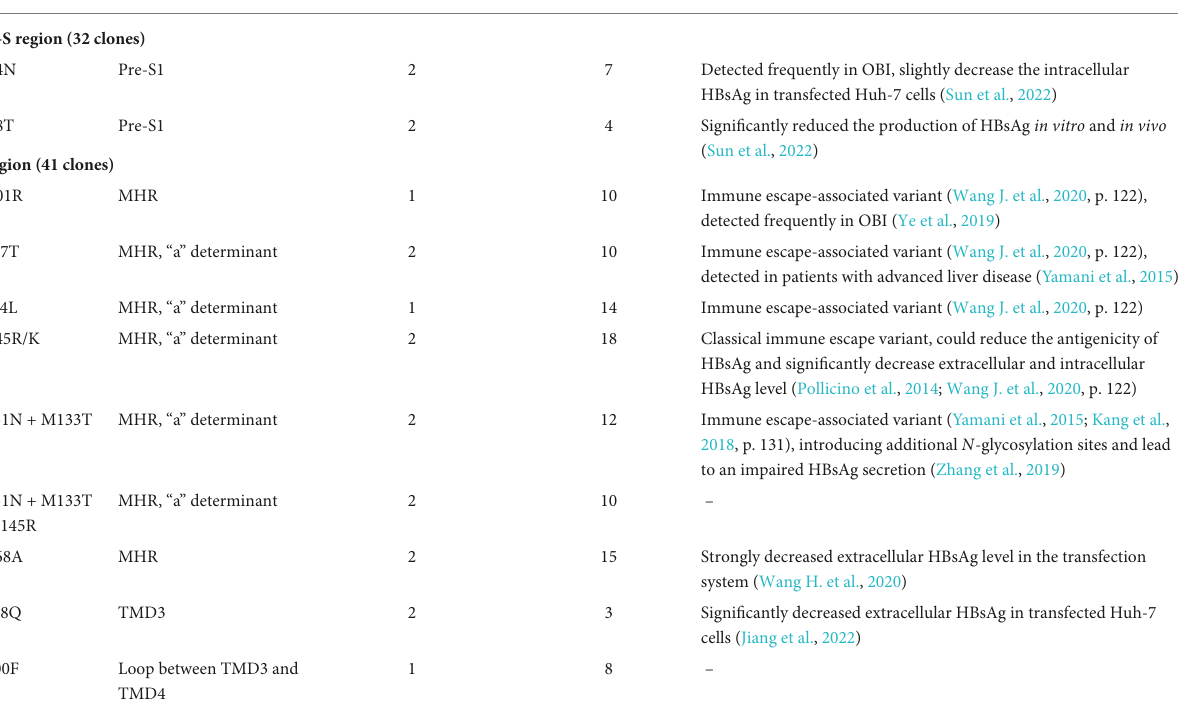
TABLE 3 Summary of common viral mutations in four HBsAg-/anti-HBs+/HBeAg+ samples of genotype B. Mutations Position Number of samples Number of clones with the mutation with the mutation